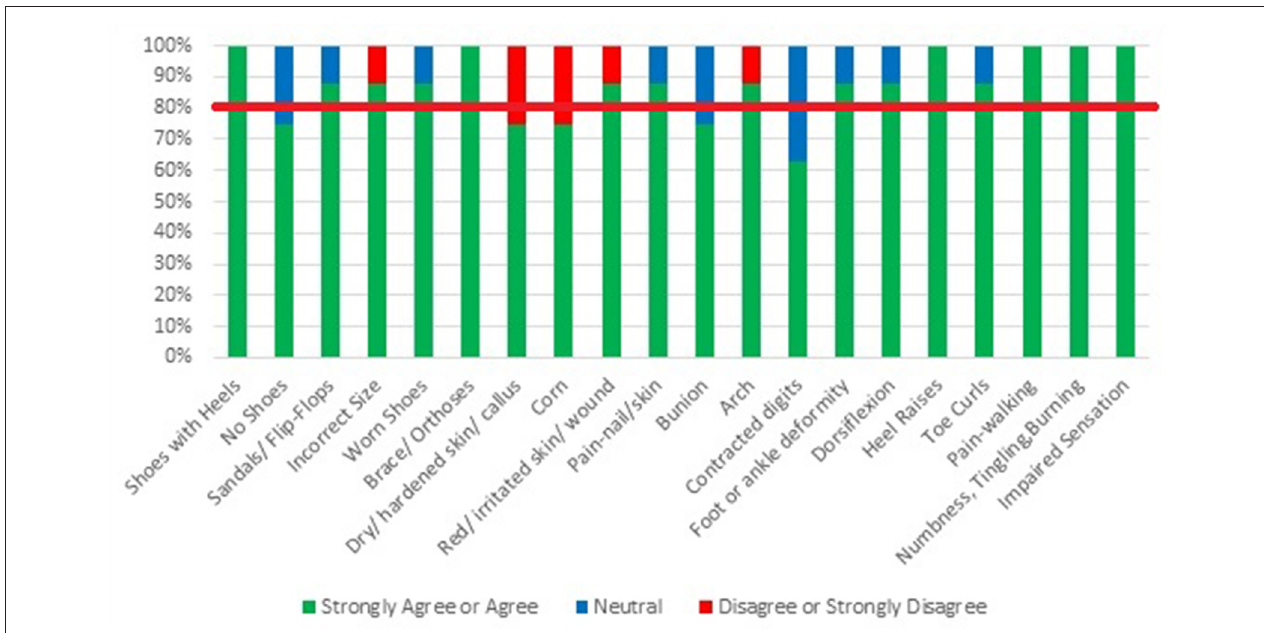
FIGURE 2 | Results of modified Delphi-Round 2: expert opinion regarding the inclusion of items on the Feet/Footwear-Related Fall Risk Screening Tool.